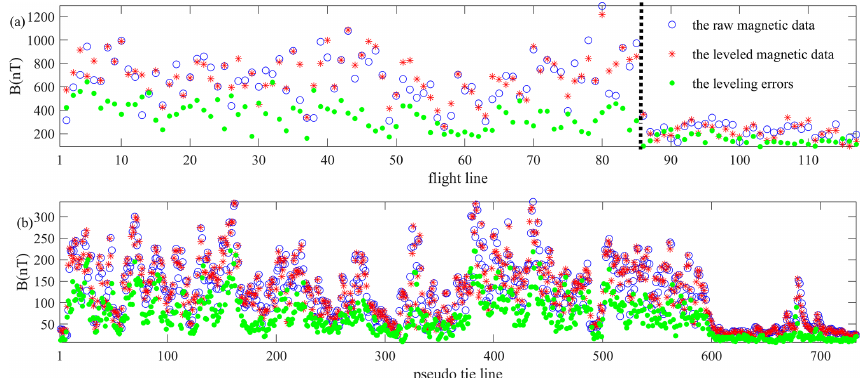
Figure 2. The maximum values of the gradients. (a) The horizontal gradients. (b) The vertical gradients.